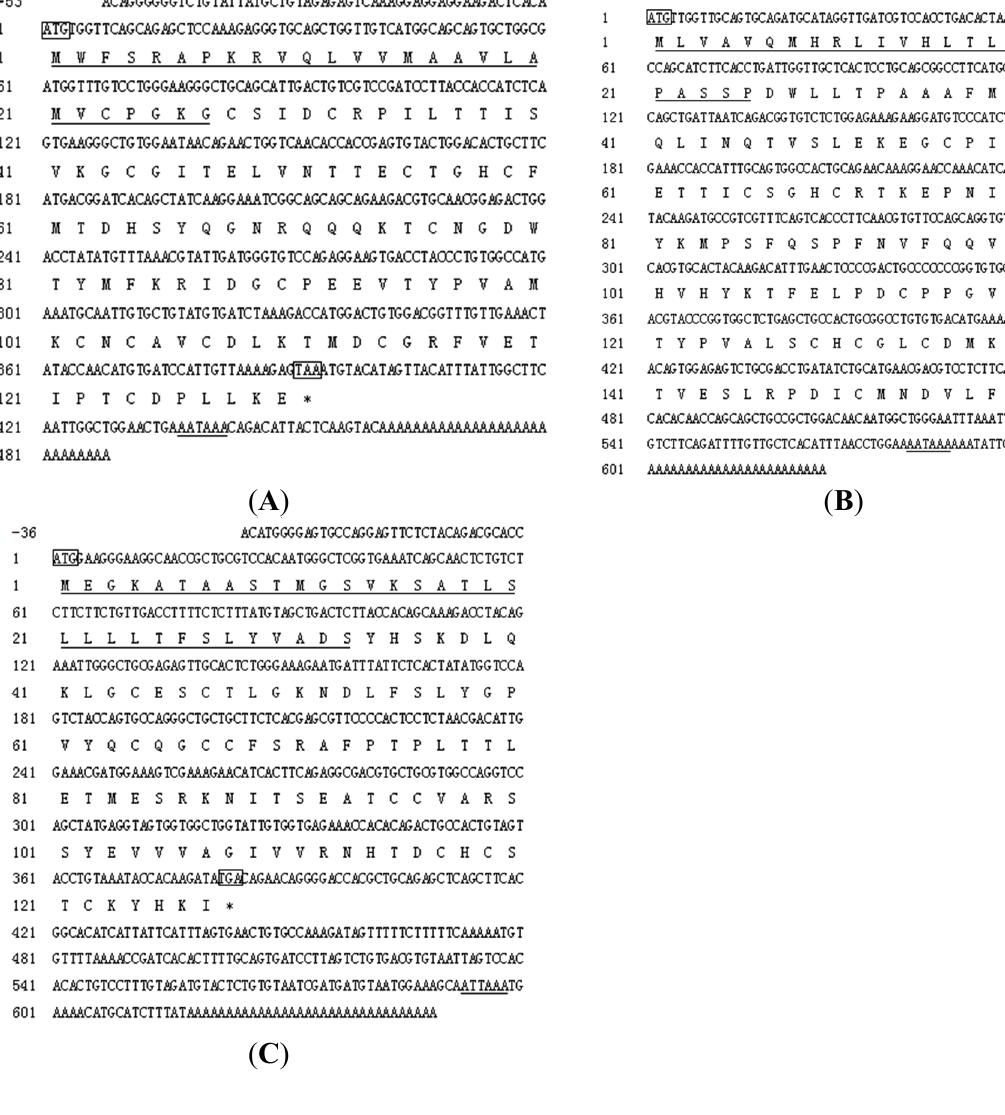
Figure 3. Nucleotide and deduced amino acid sequences of C. semilaevis gonadotropin subunits (FSH β ( A ), LH β ( B ) and CG α ( C )). Nucleotides (upper sequence) and amino acid (lower sequence) are numbered on the left. Amino acids that comprise the signal sequence are underlined. The start and stop codon are shown by boxes. The stop codon (TAA or TGA) is indicated by asterisks (*). The putative polyadenylation signal (AATAAA or ATTAAA) is